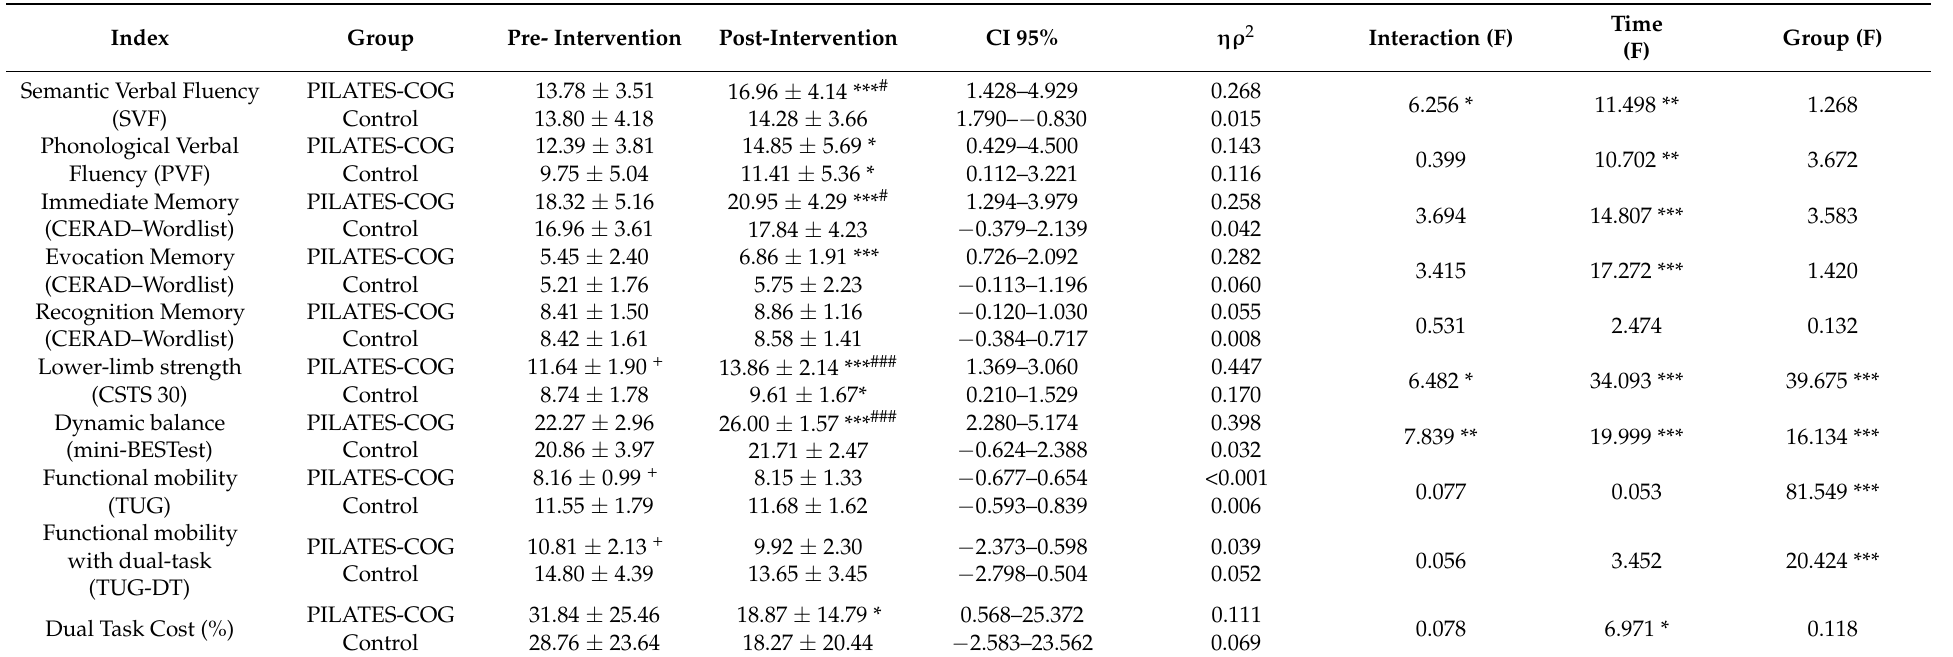
Table 2. Cognitive, Physical Functioning, and Dual-task Performance Scores in the Pre- and Postintervention